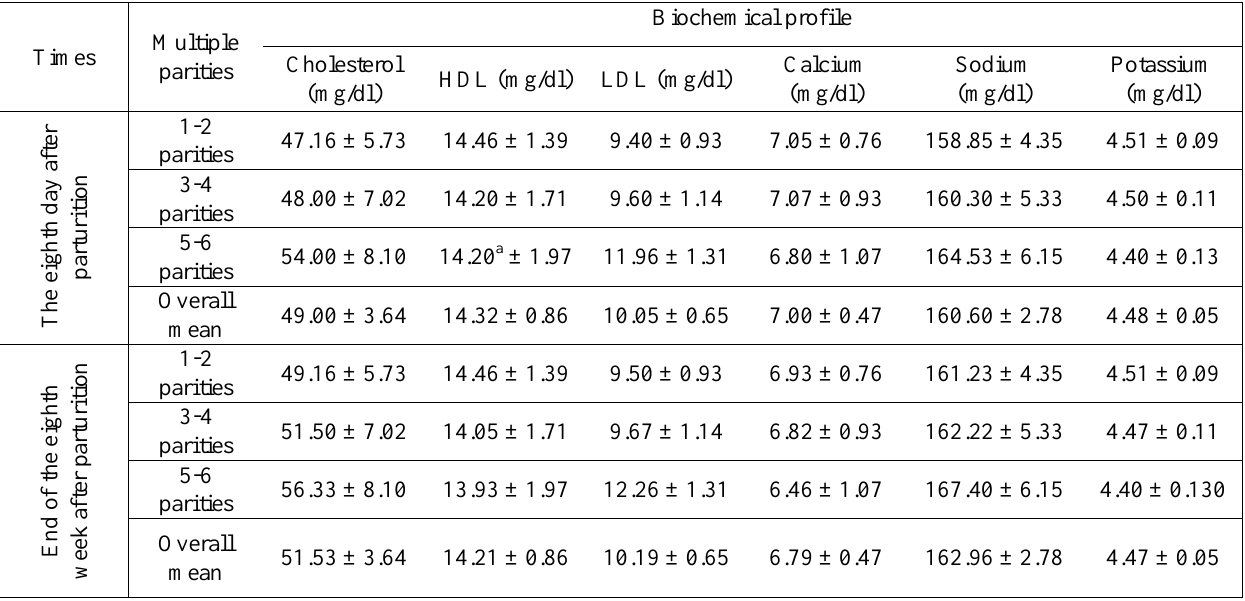
Table 2: The variation (mean ± S.E) of Maghrebi she–camels blood substances and ions among different parities in the first and eighth weeks after parturition